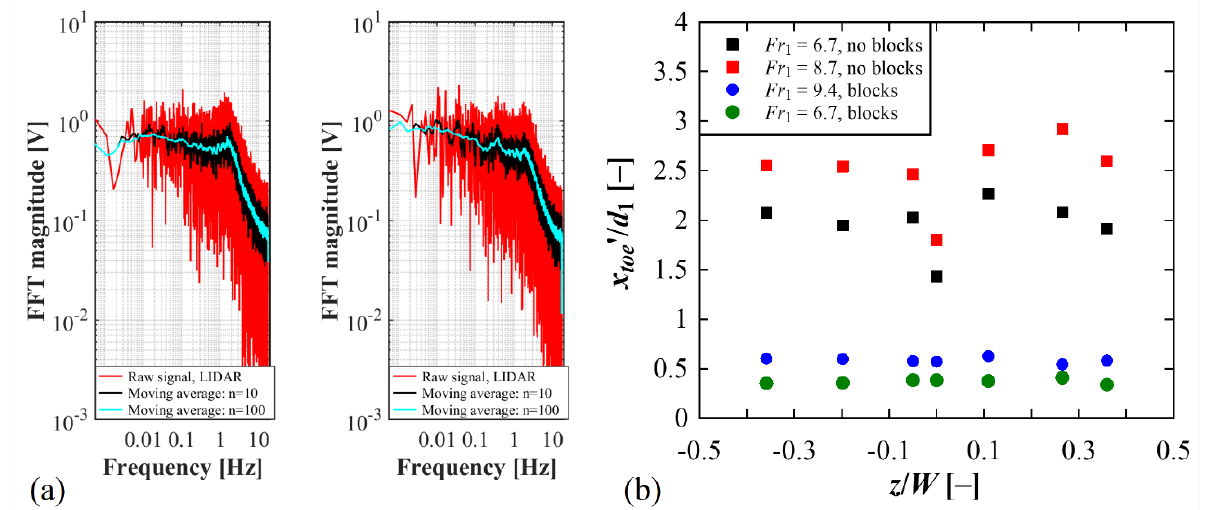
Figure 6. LIDAR measurements of advanced free-surface properties: ( a ) examples of FFT frequency spectrum for q = 0.19 m 2 /s, Fr 1 = 6.7, and Re = 1.9 × 10 5 without super-cavitating blocks at x / L = 0.45 and z / W = 0.23 ( left ), z / W = 0.4 ( right ); ( b ) standard deviations of jump toe locations ( x toe ’ / d 1 ).